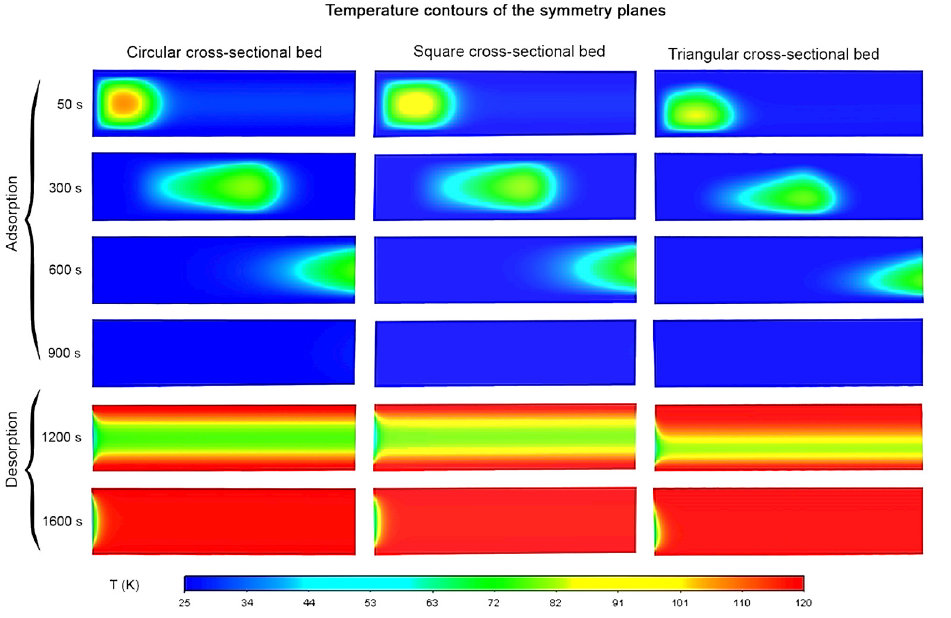
Figure 3. Temperature contours for the investigated beds at selective adsorption and desorption times.